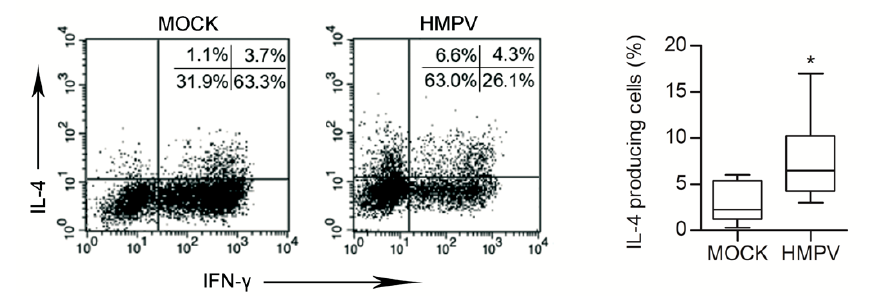
Figure 3. DCs primed by secretomes of HMPV-infected L-HMVECs induce Th2 polarized cells. Purified CD4 + T cells were co-cultured with allogenic DCs pretreated with mock or HMPV-infected L-HMVEC secretomes harvested at 21 days PI. After 7 days cells were treated with PMA, Ionomycin, and Brefeldine, then fixed, permeabilized, stained for IFN- γ and IL-4 and analysed in flow cytometry as described in Section 2. Cell gating was on CD4 + T cell population. In the left panel intracellular cytokine expression is represented as dot-plots. Numbers indicate the % of positive cells in each quadrant. Data represent one of 10 independent experiments performed with cells from di ff erent donors. Box-plot graph (right panel) represents % of IL-4-producing cells generated after the allogenic culture of naïve CD4 T cells with DCs treated with mock or HMPV-infected L-HMVEC secretomes. Lower quartile, median, upper quartile, and largest observations are represented. * p < 0.05.